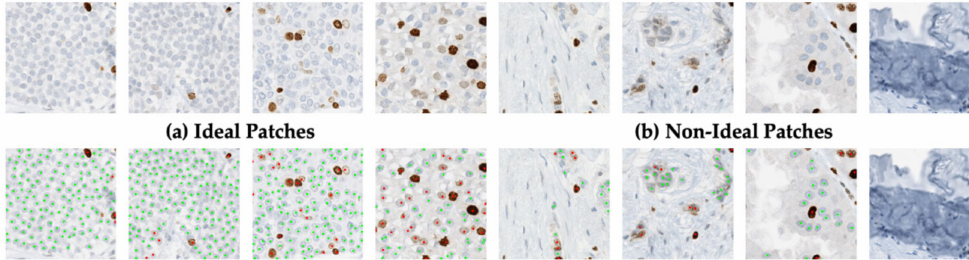
patches, filled with folds, stromal tissue, epithelial cells, inflammatory cells and combination of tumor/nontumor